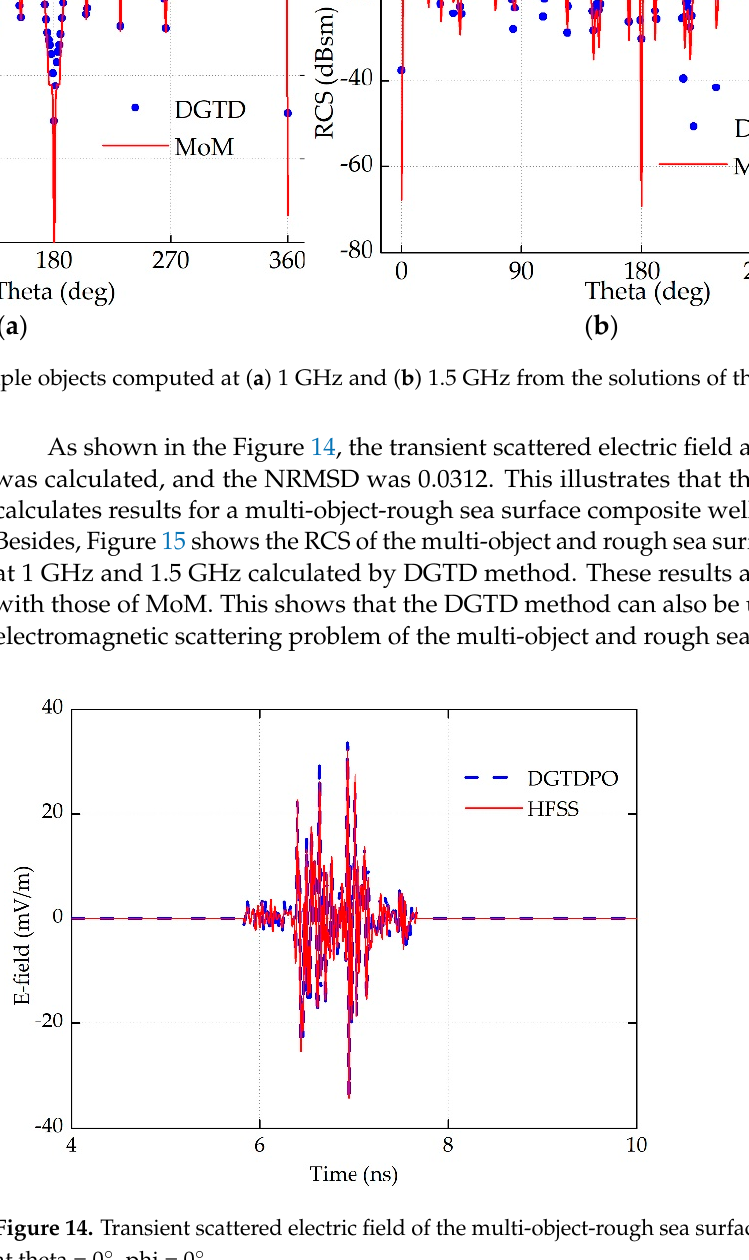
puted at theta = 0°, phi = 0°. at theta = 0 ◦ , phi = 0 ◦ .